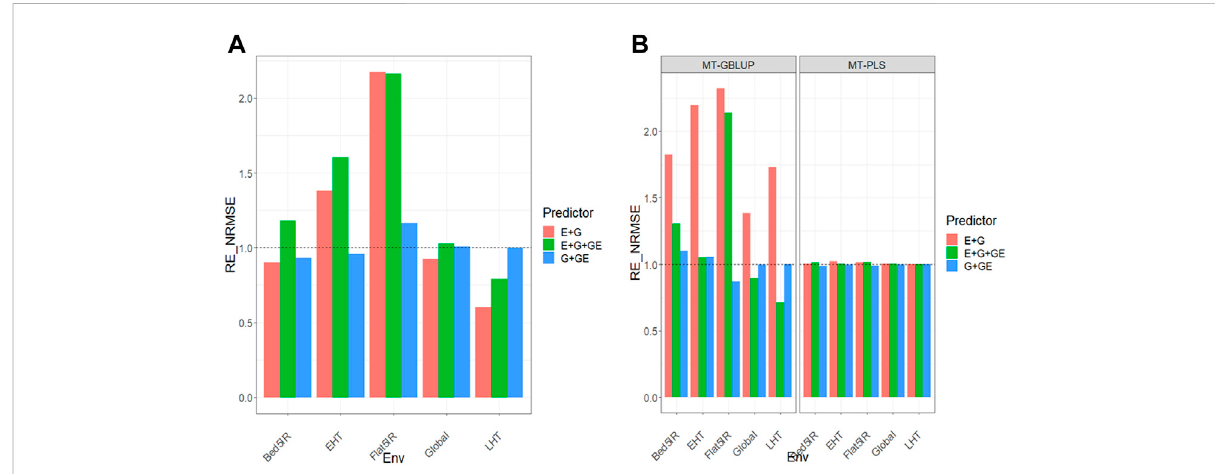
FIGURE 1 (A) Relative ef fi ciency in terms of normalized root mean square error (RE_NRMSE) computed by dividing the NRMSE under the multi-trait best linear unbiased predictor model (MT-GBLUP) by the NRMSE of the multi-trait partial least square regression method (MT-PLS). Prediction performance is reported across traits for each environment and across environments (Global) in dataset 1 (EYT_1), also with three predictors (E + G, E + G + GE and G + GE). When the RE_NRMSE > 1 the MT-PLS outperform in terms of prediction performance (lower NRMSE) the MT-GBLUP method. (B) Relative ef fi ciency in terms of normalized root mean square error (RE_NRMSE) computed by dividing the NRMSE of either the UT best linear unbiased predictor model (UT-GBLUP) or UT partial least square regression method (UT-PLS), by the NRMSE of either MT-GBLUP or MT-PLS method.Predictionperformanceisreportedacrosstraitsforeachenvironmentandacrossenvironments(Global)indataset1(EYT_1),alsowiththree predictors (E + G, E + G + GE and G + GE). When the RE_NRMSE > 1 the multi-trait method outperform in terms of prediction performance (lower NRMSE) the UT method.